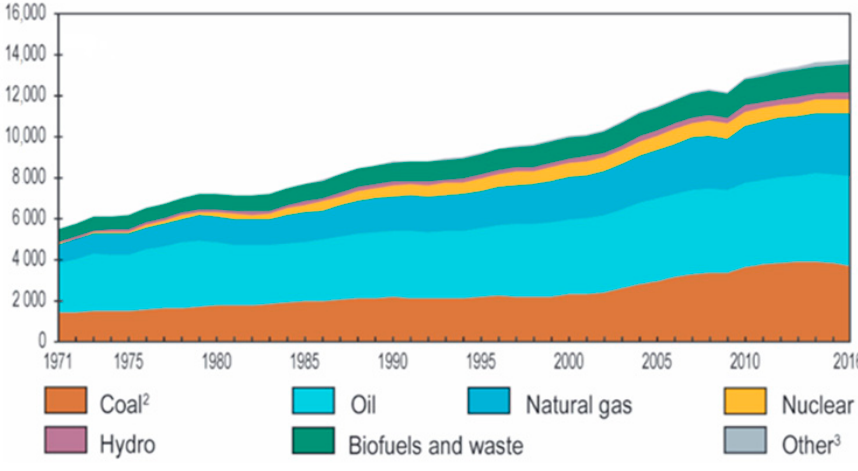
Figure 1. World total primary energy supply by fuel in 2018.